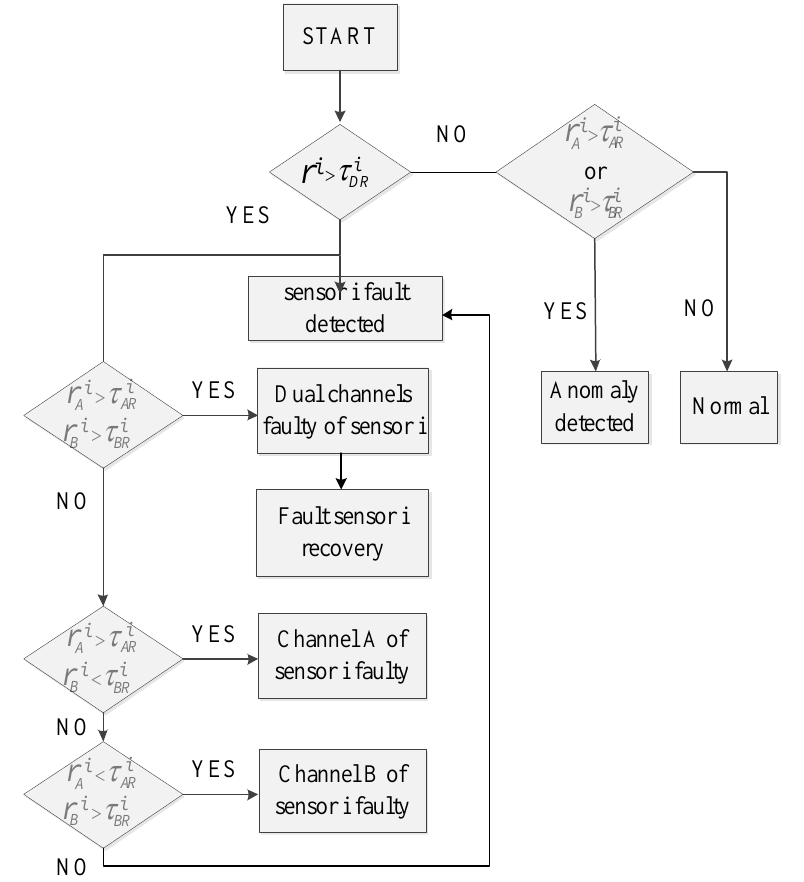
Figure 7. Dual-channel sensor fault detection, diagnosis, and recovery